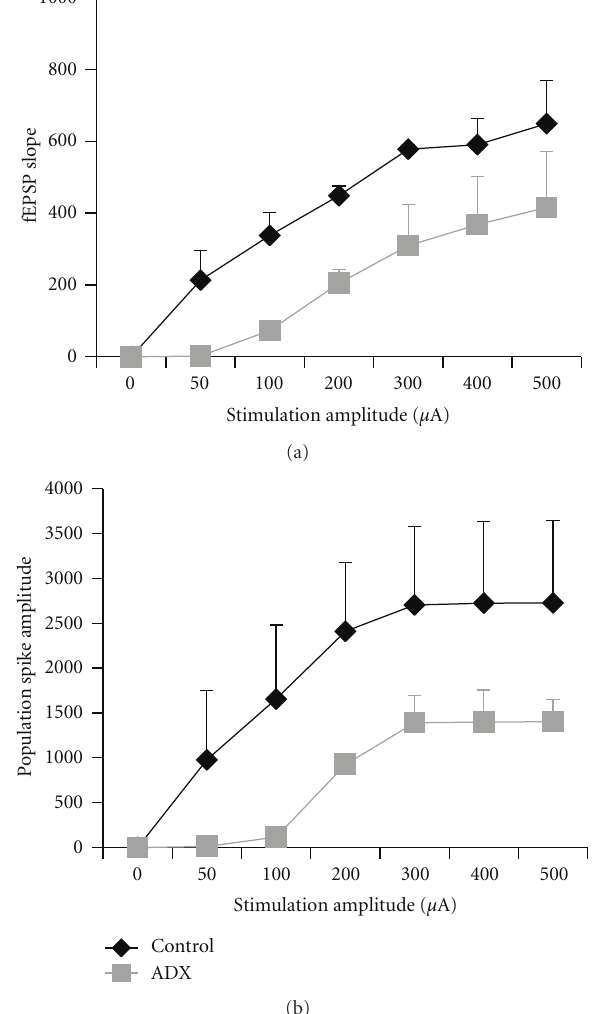
Figure 3: Pilot data assessing the electrophysiological response of the dentate gyrus after 10 weeks of adrenalectomy (ADX) followed by one-week of CORT replacement, all ADX rats were on CORT replacement at the time of recording. (a) Chronic ADX resulted in a significantly attenuated fEPSP slope relative to control rats. (b) A tendency for ADX rats to have a lower population spike amplitude compared to intact controls was apparent. Error bars represent standard error of the